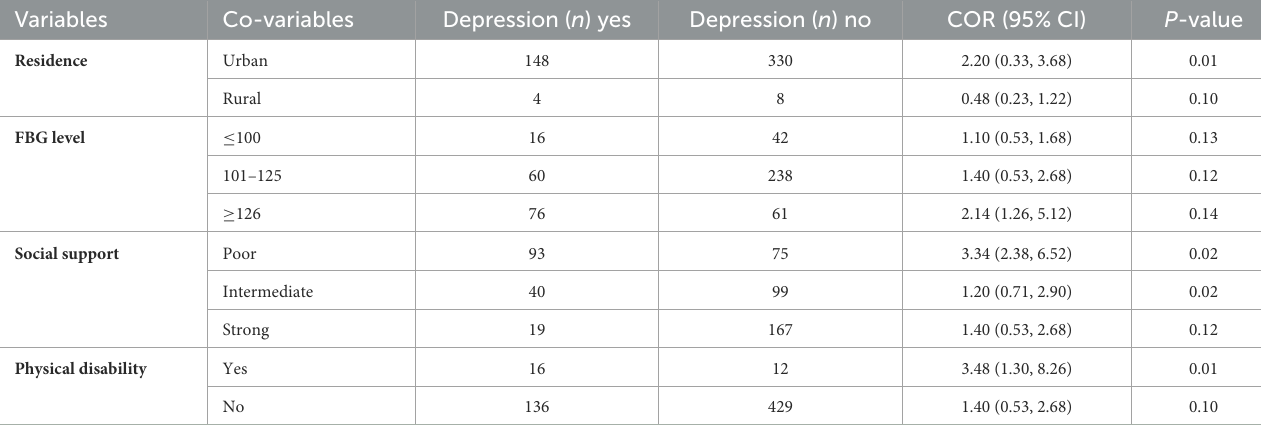
TABLE 3 Bivariate analysis of depression among patients with diabetes mellitus attending the outpatient department at SINA Clinics [August–September 2022] ( N = 493, n = 152). Variables